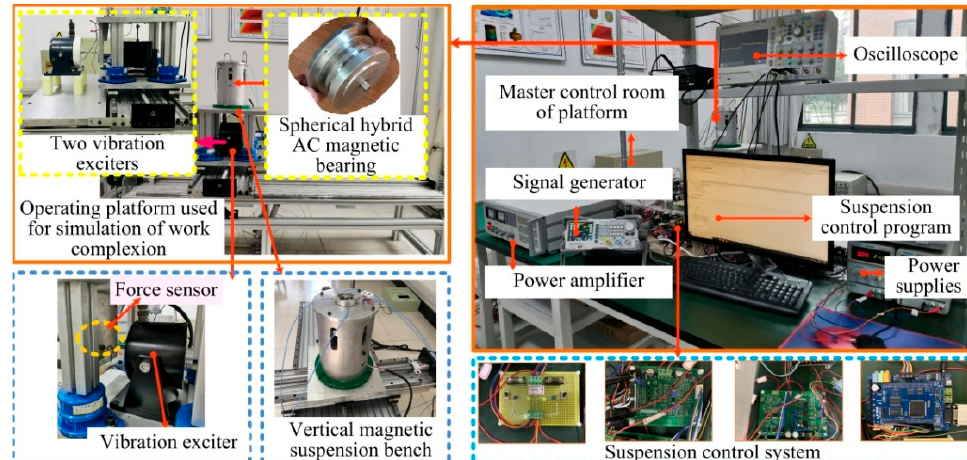
Figure 10. Experimental platform.